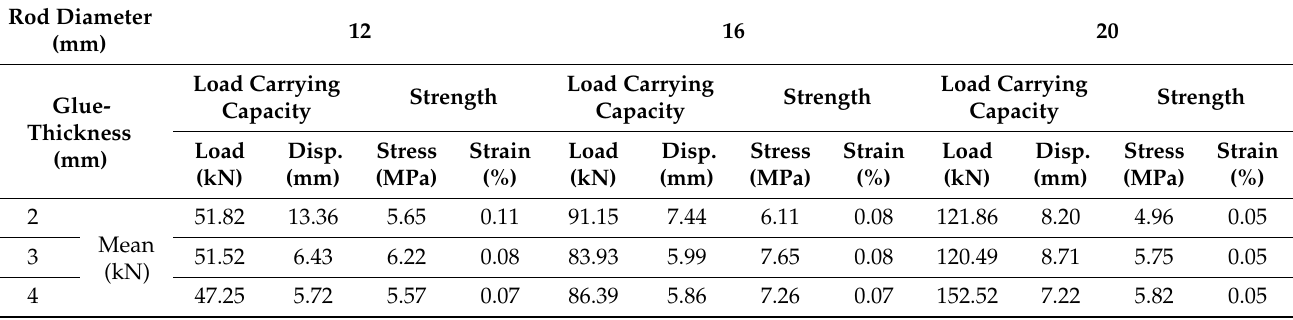
Table 5. GRPS0 ◦ of Glued-In Parallel to Grain Direction for Rod 12 mm, 16 mm and 20 mm